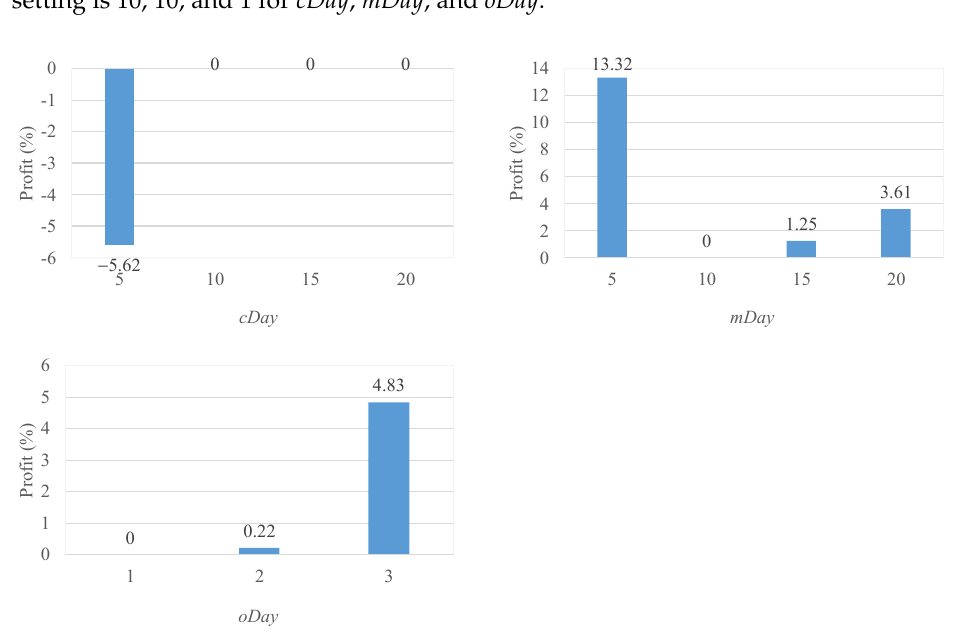
Figure 8. Profits from different parameter settings on three-year dataset (2010–2012).